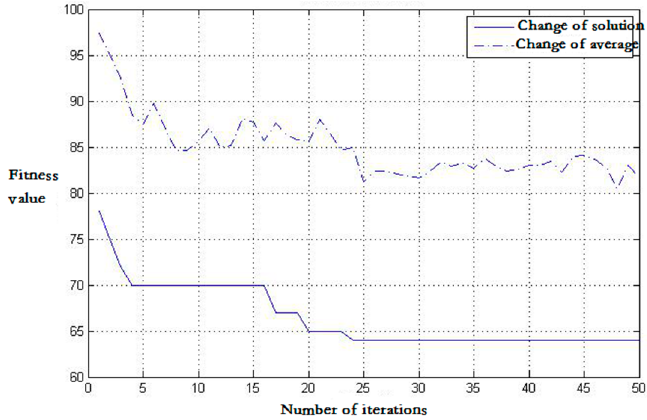
Figure 6. Single target algorithm search process.